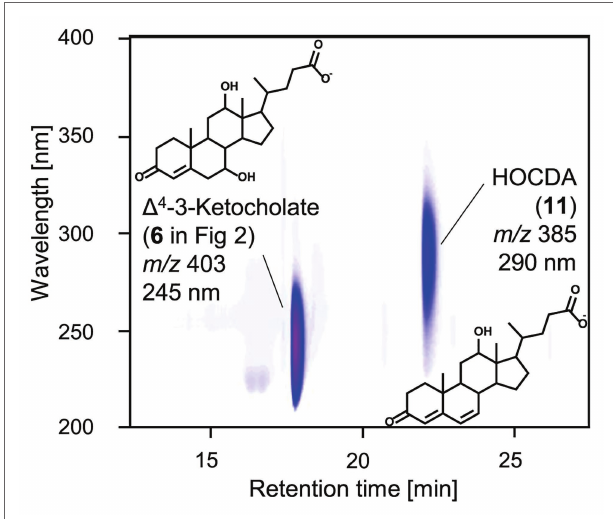
FIGURE 3 | 3D-UV-chromatogram showing Δ 4 -3-ketocholate ( 6 in Figure 2 ) and HOCDA ( 11 ) in an enzyme assay with 3-ketocholate as substrate, cell extracts of Escherichia coli MG1655 pBBR1MCS-5:: 5 β -Δ4-kstd1 as well as E. coli MG1655 pBBR1MCS-5:: hsh2 and K 3 Fe(CN) 6 as electron acceptor. Samples were analyzed by high-performance liquid chromatography coupled to mass spectrometry (HPLC-MS) and steroid compounds were identified based on retention time, absorbance spectrum, and mass. Masses are indicated for the respective deprotonated acids.